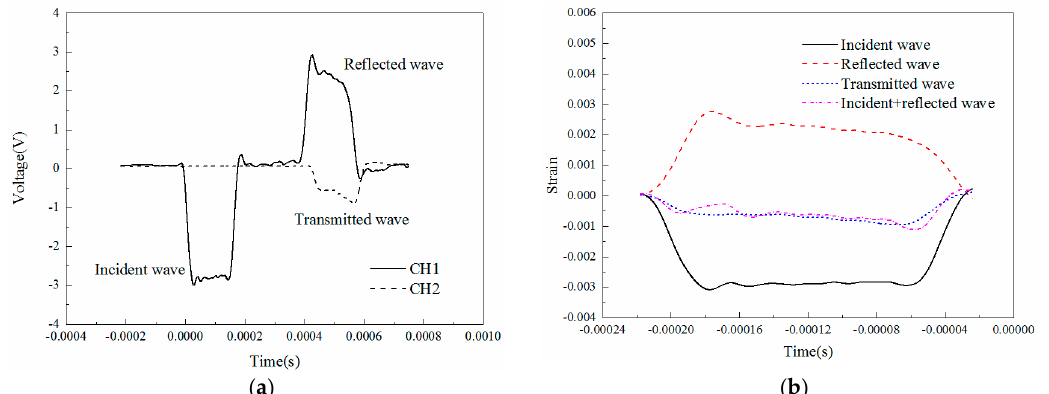
Figure 2. Typical SHPB wave forms for specimen. ( a ) Original voltage signals measured by strain gauges; ( b ) strain signals transformed from voltage signals.